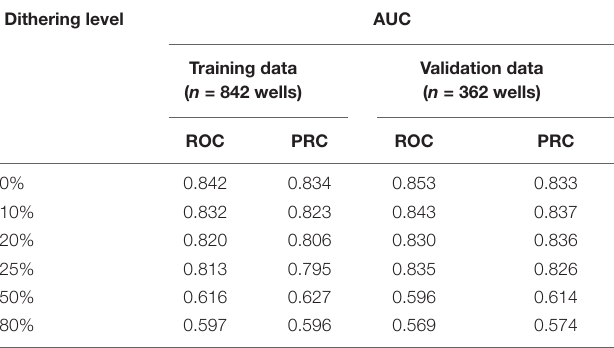
TABLE 3 | Computed areas under the receiver operating characteristic and precision-recall curves of the training and validation datasets at each dithering level.